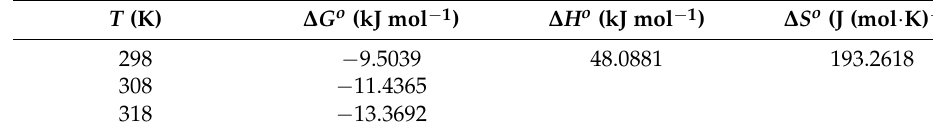
Table 3. Thermodynamic parameters of adsorption for fluoride removal.